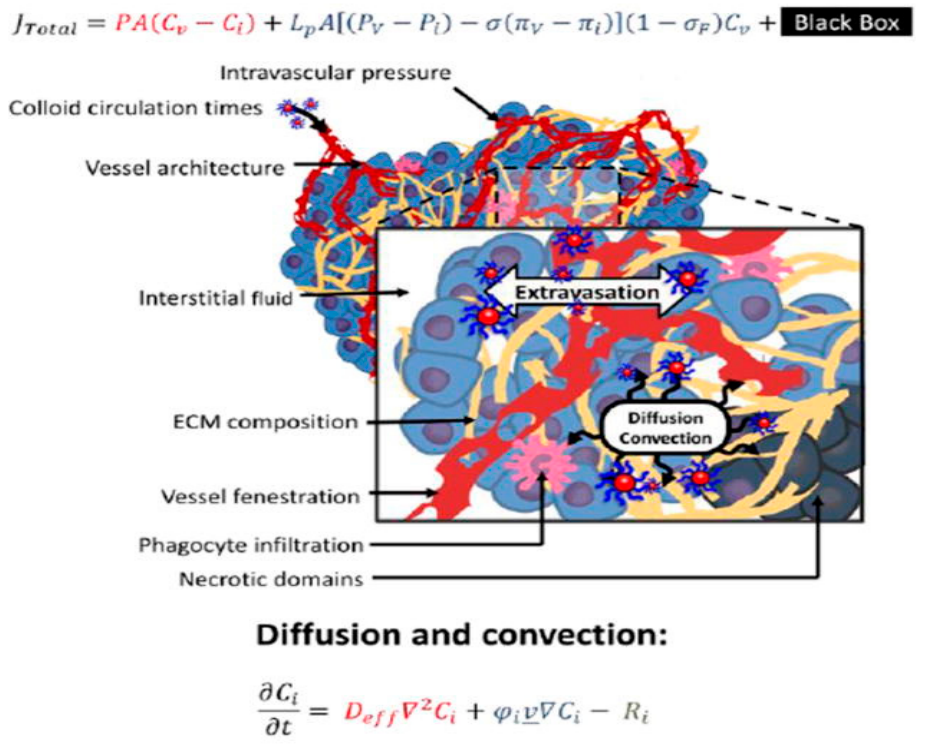
Figure 1. The two phenomena of extravasation and later diffusion and convection of the colloid in the extracellular matrix both result in enhanced permeation and retention of the nanoparticles [32].